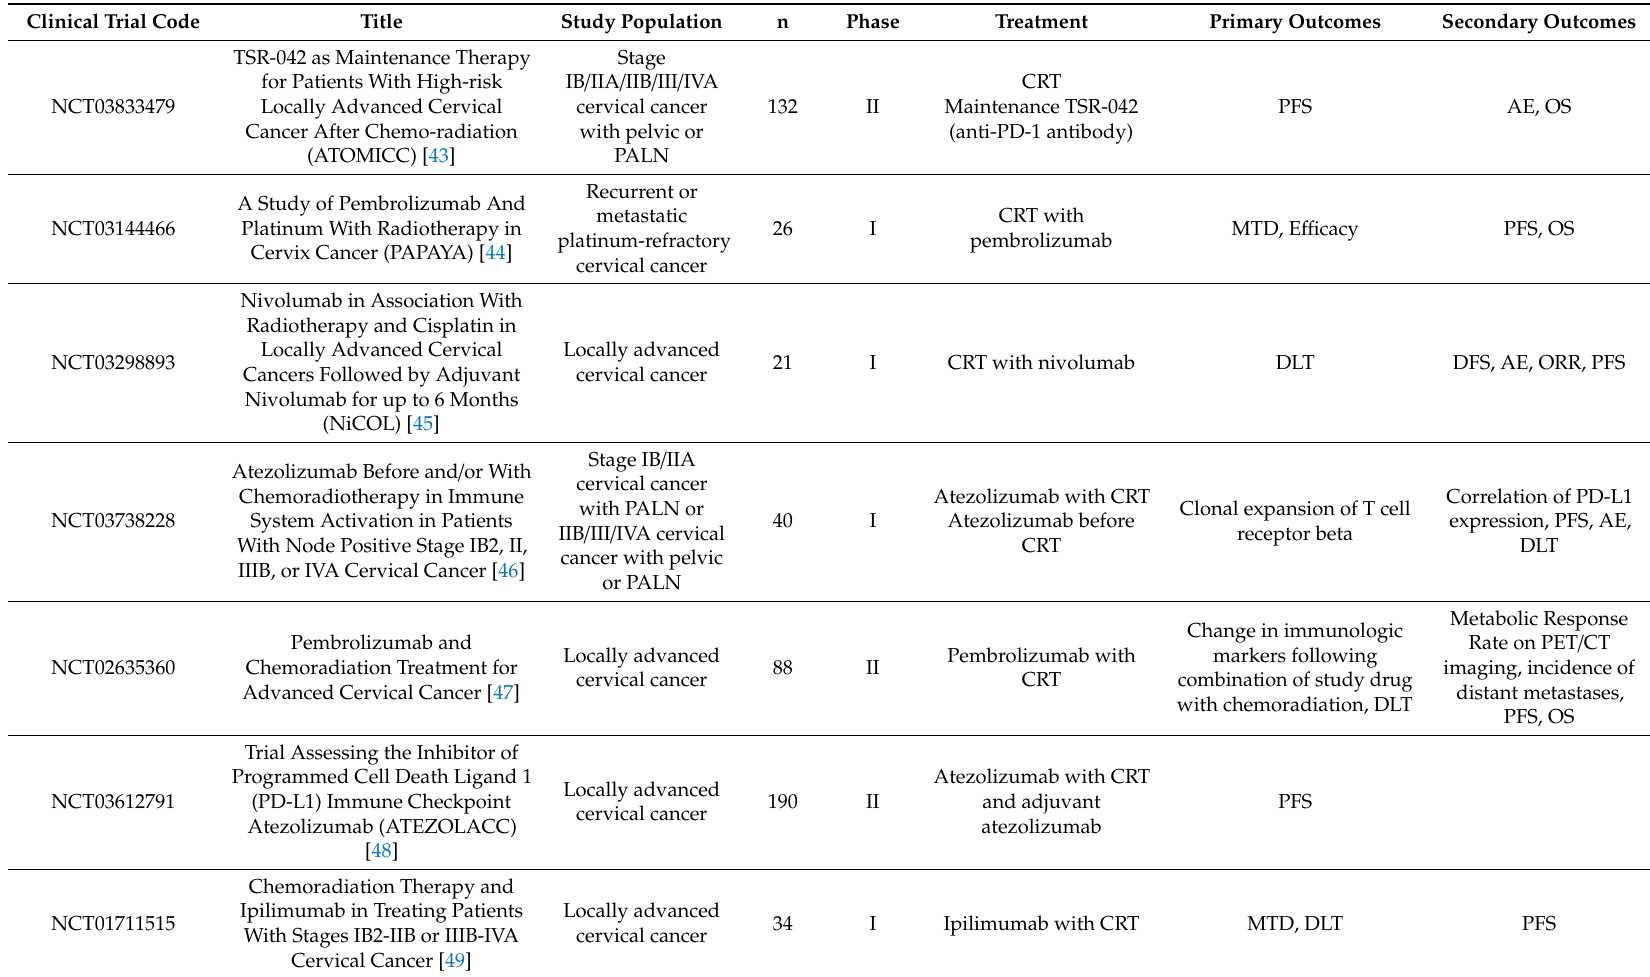
Table 3. Ongoing clinical trials of immunotherapy for cervical cancer (combination with